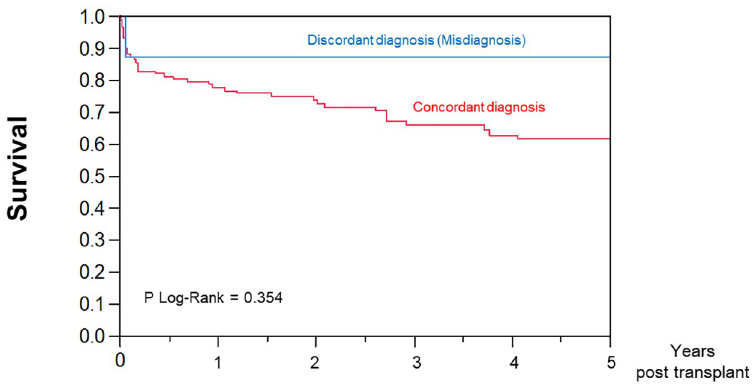
Fig 2. Survival curves among patients with concordant and discordant diagnosis between pre-transplant clinical diagnosis and post-transplant pathological findings.